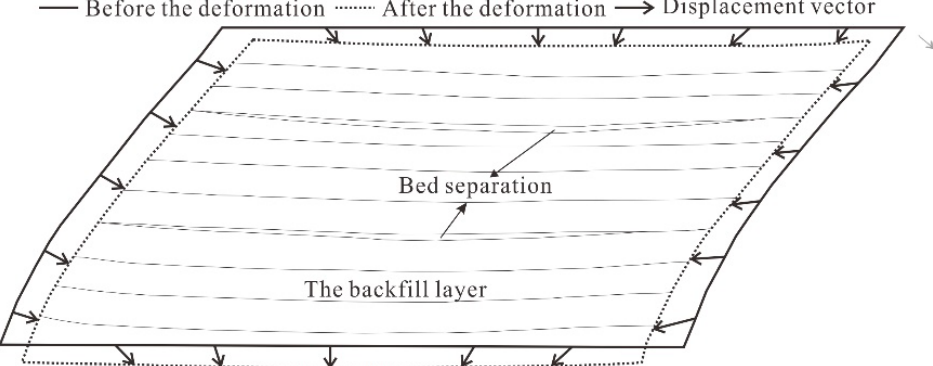
Figure 10. Deformation characteristic of a large volume of backfill.